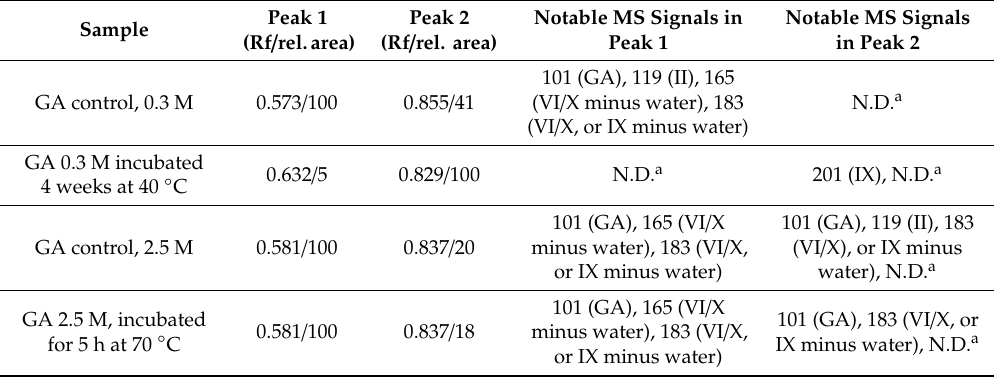
Table 2. LC-MS chromatographic results and corresponding notable MS data (where assignments